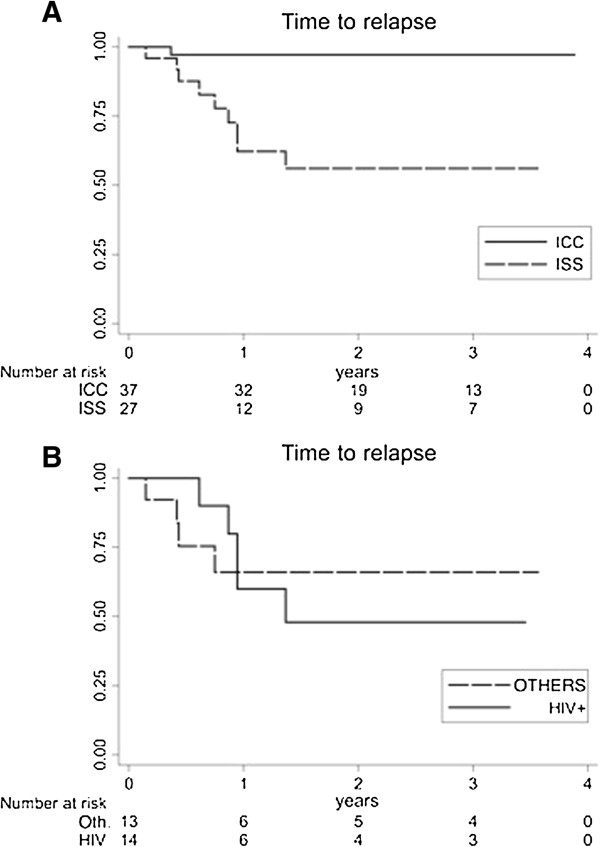
Kaplan-Meyer analysis of Relapse-free time after the first Visceral Leishmaniasis event among observed patients. Panel A. Time to relapse (in days) in Immunocompetent(ICC)vs. Immunocompromised (ISS) pts. Log-rank test for equality of survivor functions (chi2 = 0.0002); Wilcoxon (Breslow) test for equality of survivor functions (Pr > chi2 =0.0004). Panel B. Time to relapse (in days) in Immunesuppresed pts.: HIV + vs. other causes (Others). Log-rank test for equality of survivor functions (chi2 = n.s.); Wilcoxon (Breslow) test for equality of survivor functions (Pr > chi2 = n.s.).